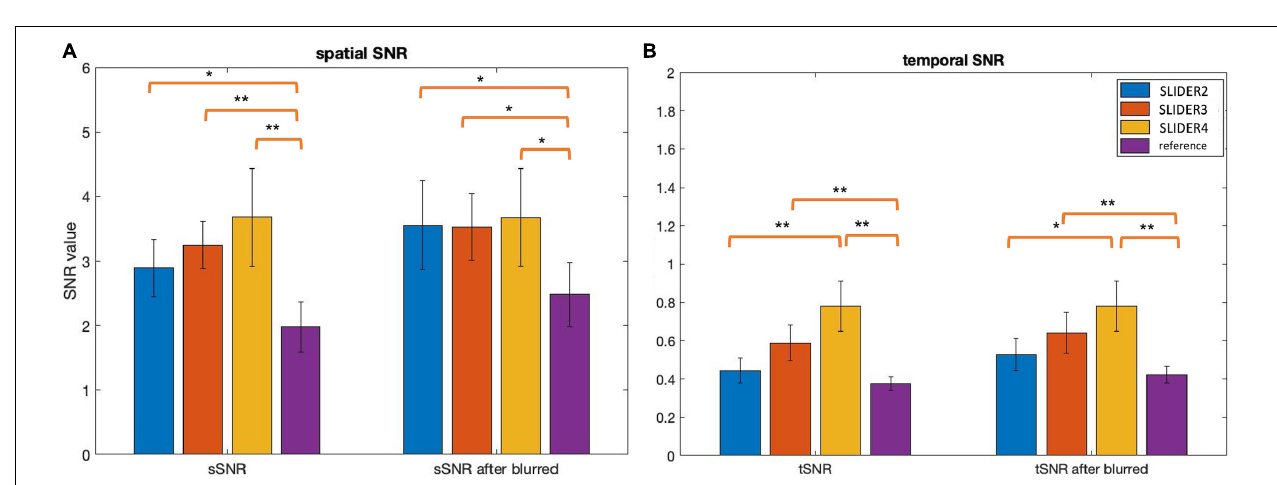
FIGURE 5 | Spatial and temporal SNR before and after controlling slice blurring. (A) Spatial SNR (sSNR) and (B) temporal SNR (tSNR) of SLIDER2/3/4 and reference scans before (left) and after applying a Gaussian kernel to control slice blurring (right). * p < 0.05; ** p < 0.01. Error bars stand for standard deviation.